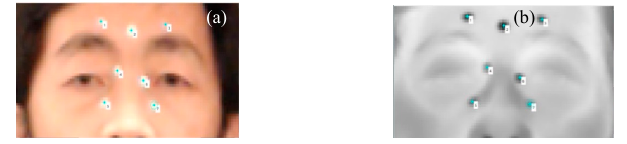
Figure 7. Aluminum Markers as control points for registration accuracy evaluation: ( a ) visible image; ( b ) IR image [19]. Table 1. Registration Matching Error (Markers in the face region as control points), pixels.